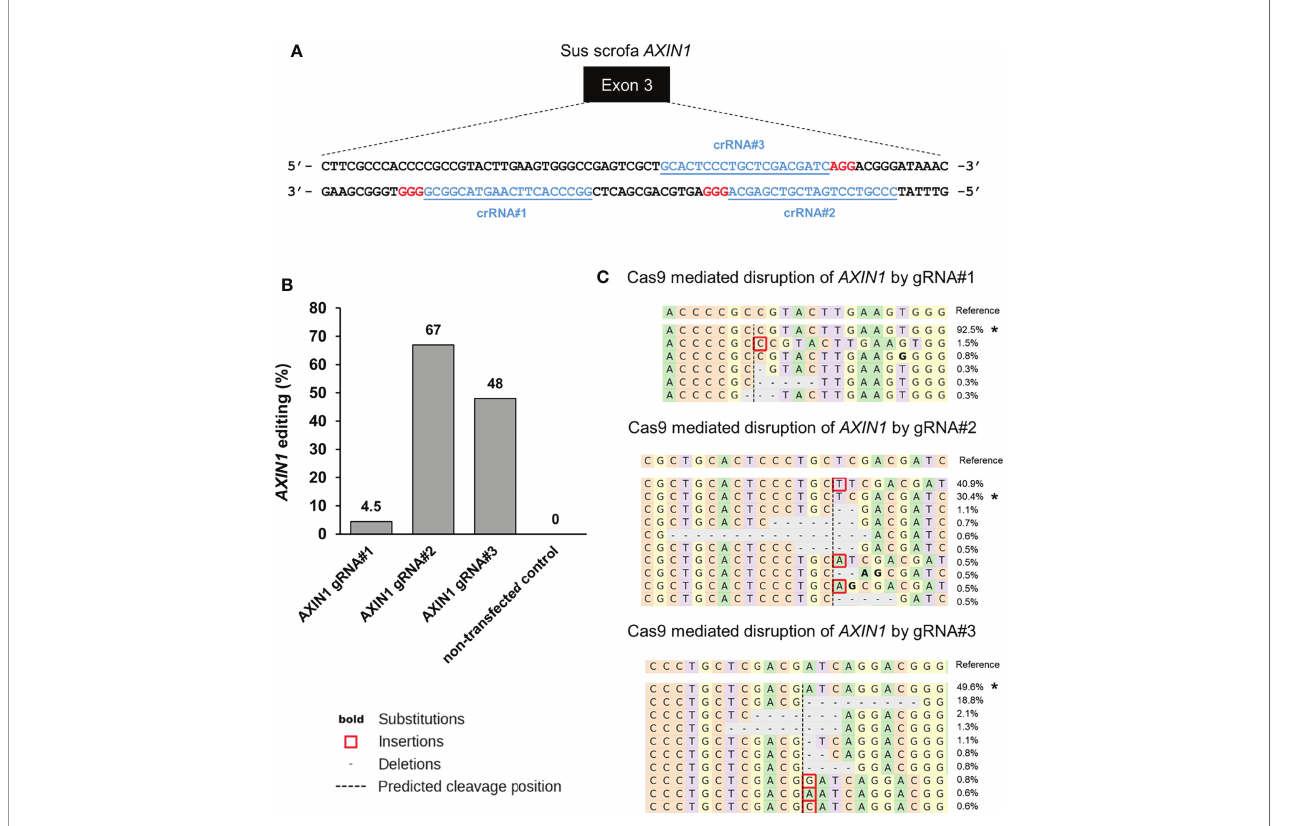
FIGURE 1 | CRISPR/Cas9 disruption of porcine AXIN1 gene. (A) Schematic representation of porcine AXIN1 locus showing the location of spacer sequences crRNA#1, crRNA#2, and crRNA#3 (underlined blue font). Protospacer adjacent motif (PAM) sequences are marked in red. (B) Comparing CRISPR/Cas9 editing ef fi ciency of three individual AXIN1 targeting gRNAs. Porcine A272 HCC cells were transfected with ribonucleoproteins (RNPs) comprising Cas9 and each gRNA. Non-transfected cells were used as control. Genomic DNA was collected two days post-transfection and analyzed by targeted NGS. The bar graph depicts the percentages (%) of total reads that displayed indels at the gRNA target site occurring as a result of non-homologous end joining (NHEJ). (C) Type and frequency of AXIN1 indels detected by targeted NGS analysis mapped to the reference sequence. The percentage of reads for each sequence are shown on the right.